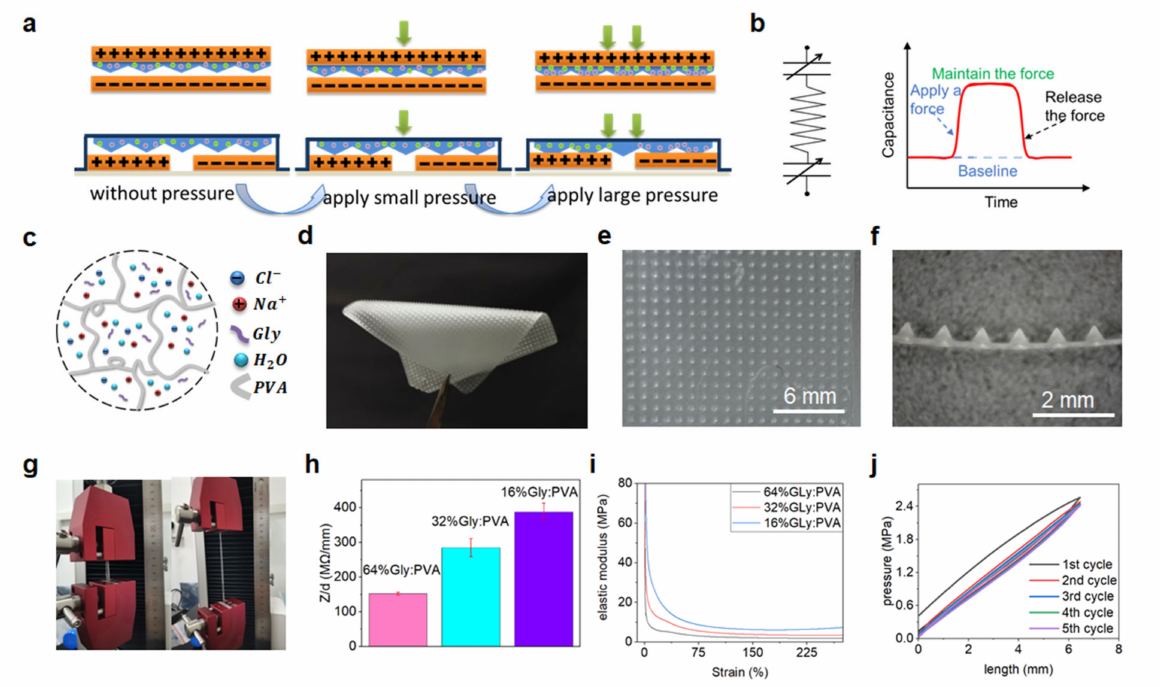
Figure 2. Construction of micro-structured solid electrolytes and the working principle of the ion- tronic pressure sensors. ( a , b ) Schematics showing the structural changes (including top-bottom electrode configuration and side-by-side electrode configuration), working principle (i.e., mechan- ical regulation of the EDL capacitance at the two electrolyte/electrode interfaces), and response behavior of the iontronic pressure sensors. ( c , d ) Schematic composition and digital picture of the PVA/NaCl/Gly/water ionic electrolytes with microstructures on the surface. ( e , f ) Optical microscope images showing the microstructure morphology created on the electrolyte surface, with uniform and periodic microstructures observed clearly. ( g ) Photographs showing the elasticity and stretchability of the PVA/NaCl/Gly/water ionic electrolytes. ( h ) Ionic impedance of PVA/NaCl/Gly/water elec- trolytes with different Gly/PVA ratios (16%, 32%, and 64%, respectively). ( i ) Stress-strain curves of PVA/NaCl/Gly/water electrolytes with different Gly/PVA ratios. ( j ) Mechanical cyclic test of